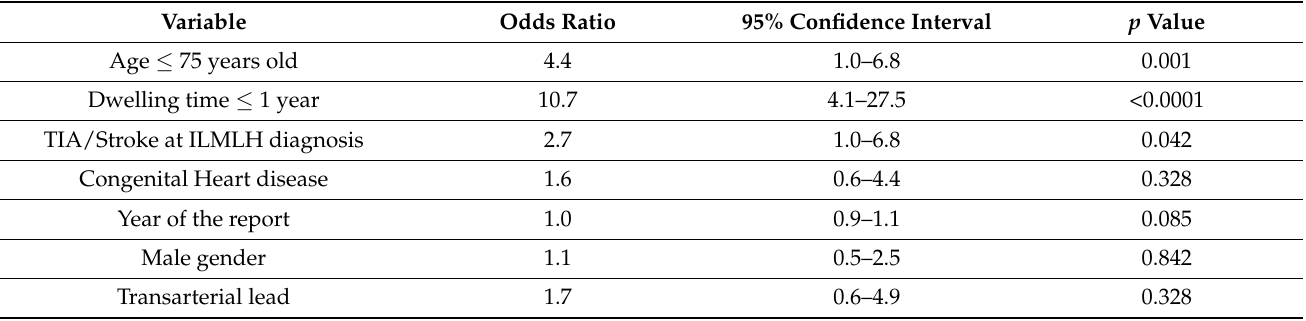
Table 5. Predictive factors of lead extraction. Multivariable logistic regression